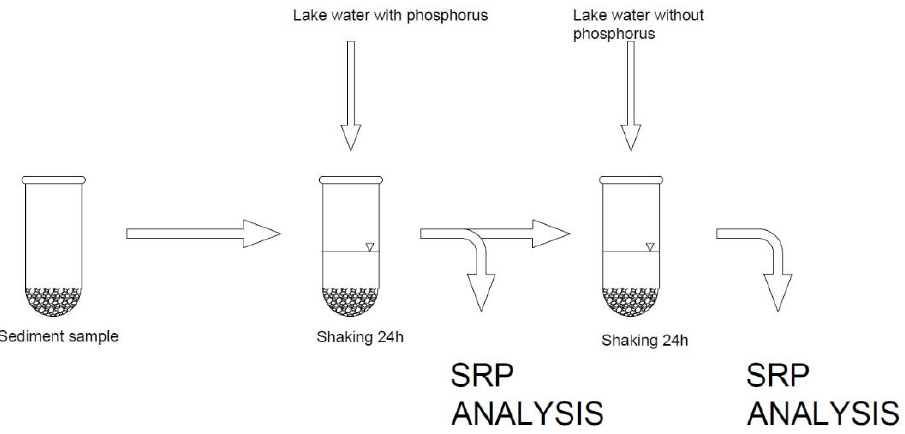
Figure 4. Scheme of P adsorption experiment procedure.